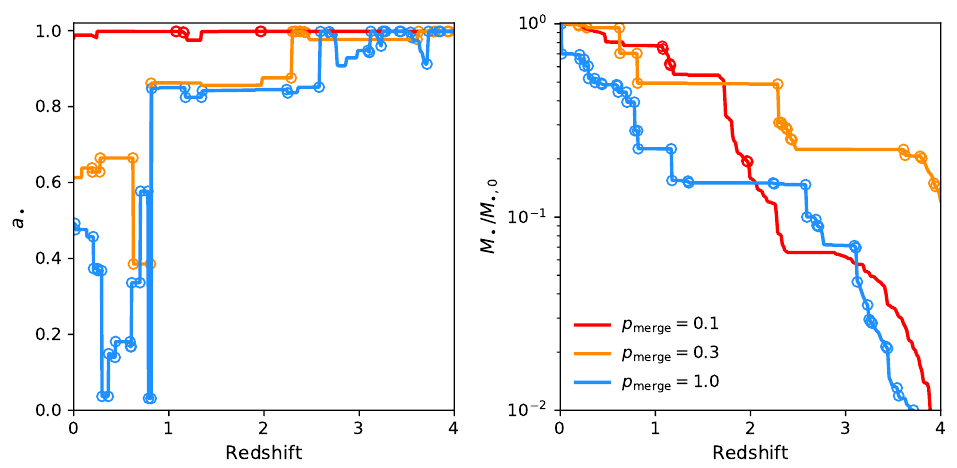
Figure 5. Example evolutionary histories of SMBH spin ( left ) and mass normalized by final mass ( right ) as a function of redshift in 10 15 M (cid:12) halos using a semi-analytic model for cosmological SMBH assembly. We demonstrate sensitivity to the merger history of SMBHs by varying a free parameter p merge , which sets the probability that a SMBH merger occurs following a major halo merger. Different colors encode different values of p merge , and open circles mark SMBH-SMBH mergers with mass ratios of at least 1:100. Many mergers occur in these massive halos, which can cause sharp jumps in